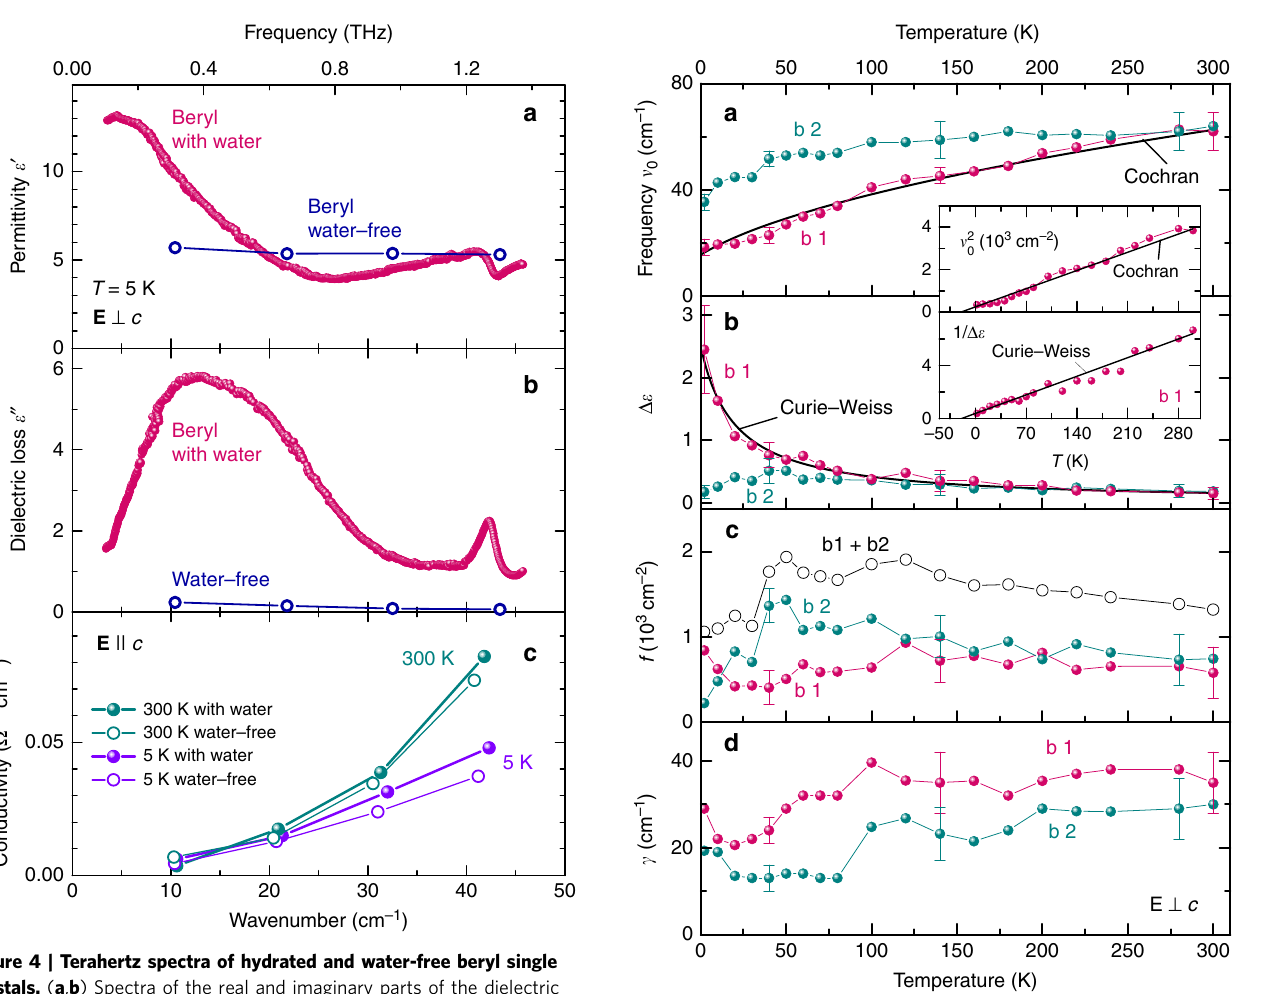
Figure 5 | Parameters used to fit the soft mode by Curie–Weiss and Cochran models. ( a – d ) Temperature dependences of the parameters of the two components of the soft mode observed in the THz spectra of hydrated beryl crystals for E > c : frequencies n i ; dielectric contributions D e i ; oscillator strengths f i ¼ D e i n i 2 of both components and of their sum (open symbols); and damping constants g i . The two components of the soft mode are labelled by b1 (magenta symbols) and b2 (cyan symbols). Inset: temperature dependences of the squared frequency and inverse permittivity of the component b1 demonstrating the Curie–Weiss, equation (1), and the Cochran, equation (2), behaviours (straight lines). The error bars correspond to the ranges of the data that provide satisfactory description of the original experimental material; that is, fitting the spectra of the complex permittivity and optical conductivity